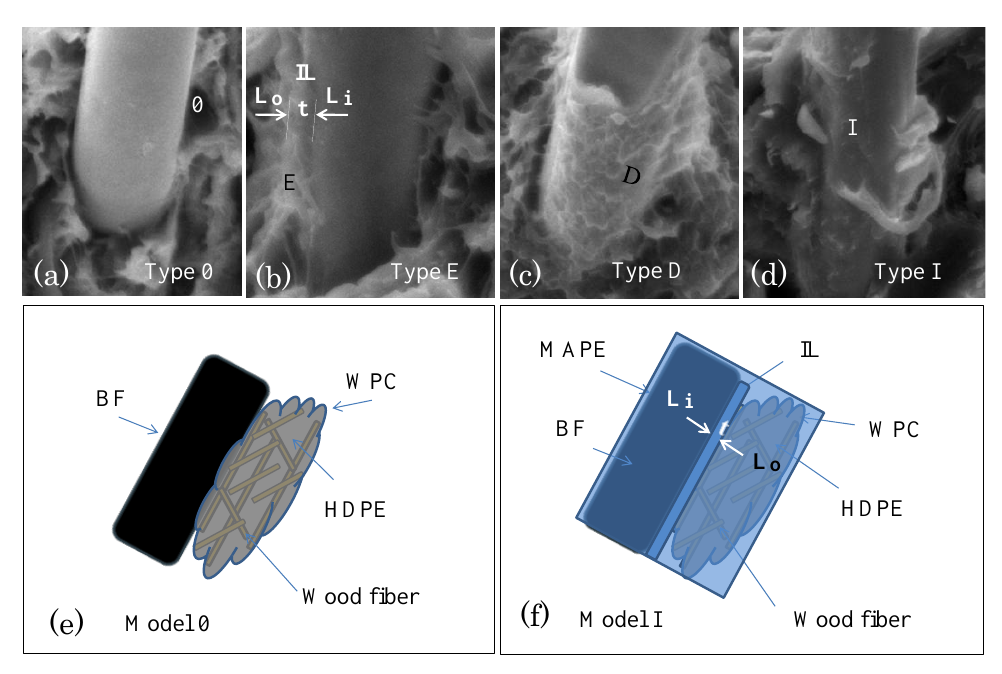
Figure 3. The interfacial layer between the BF and the WPC. ( a – d ) Interface types; ( e , f ) models before and after MAPE addition. IL: an interfacial layer, L outer faces of the IL, respectively; 0: the lack of an IL, E: partial IL, D: a wave-like IL, I: a flat IL.